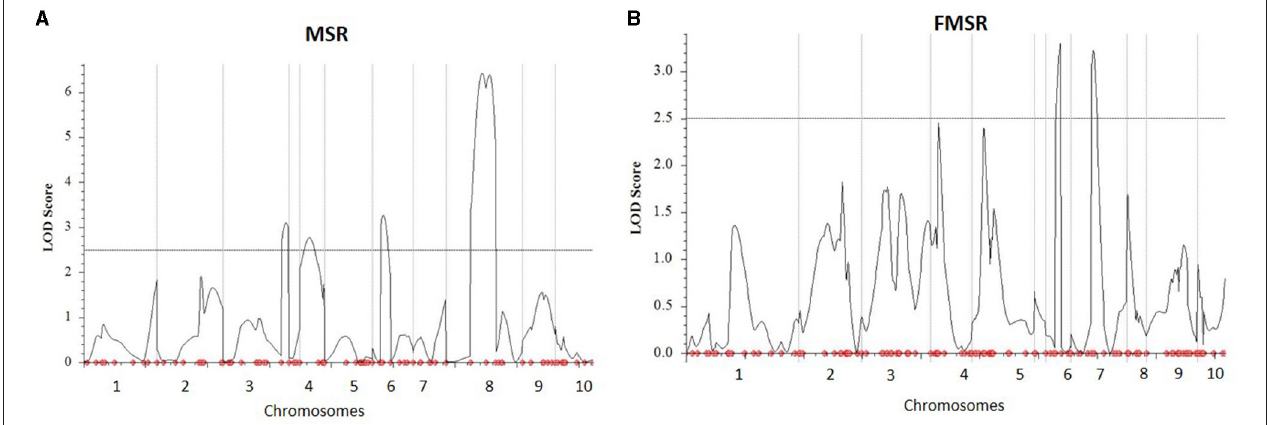
FIGURE 2 | Plot of LOD scores from quantitative trait loci (QTL) analysis for charcoal rot resistance across 10 maize chromosomes in two F2: 3 biparental populations, (A) MSR and (B) FMSR. MSR and FMSR populations were evaluated under artificial inoculation conditions by Macrophomina phaseolina . The horizontal line represents the threshold LOD value of